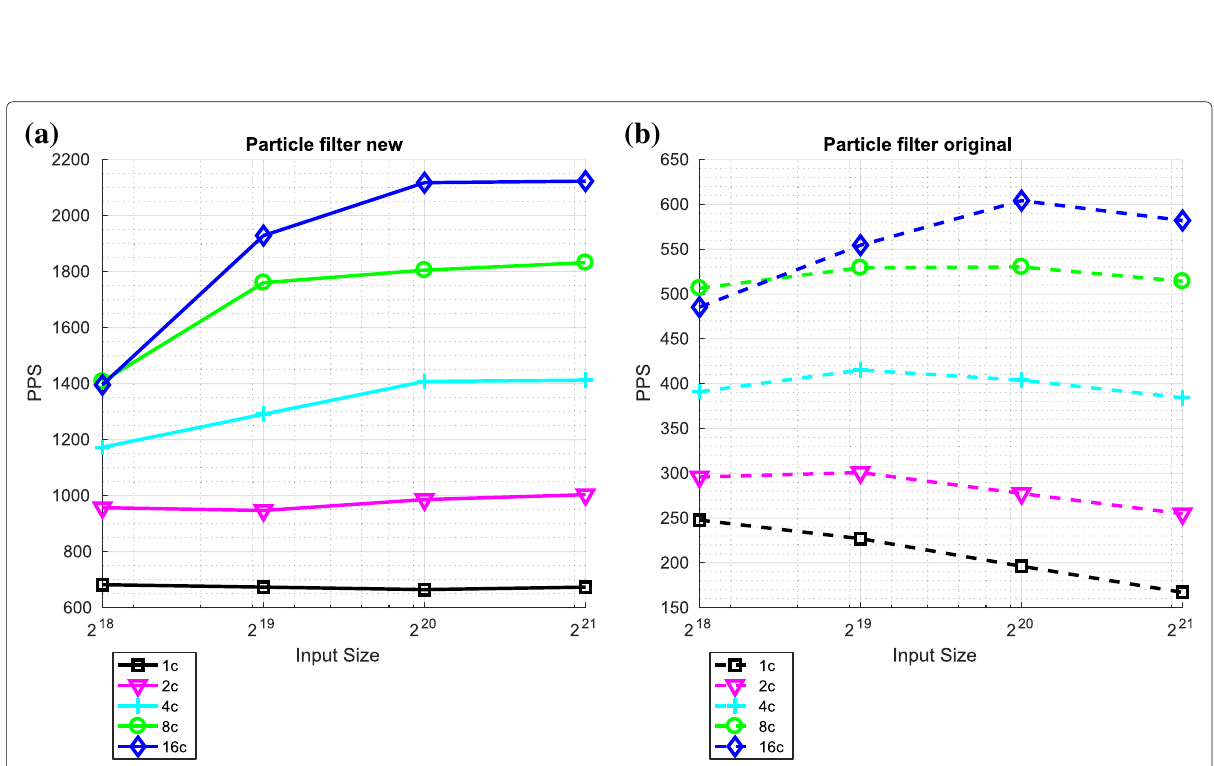
Fig. 13 Performance of the overall particle filter using the two variants of the redistribution component. a Particle filter O (cid:2) N ( log ) 3 filter O 2 N P